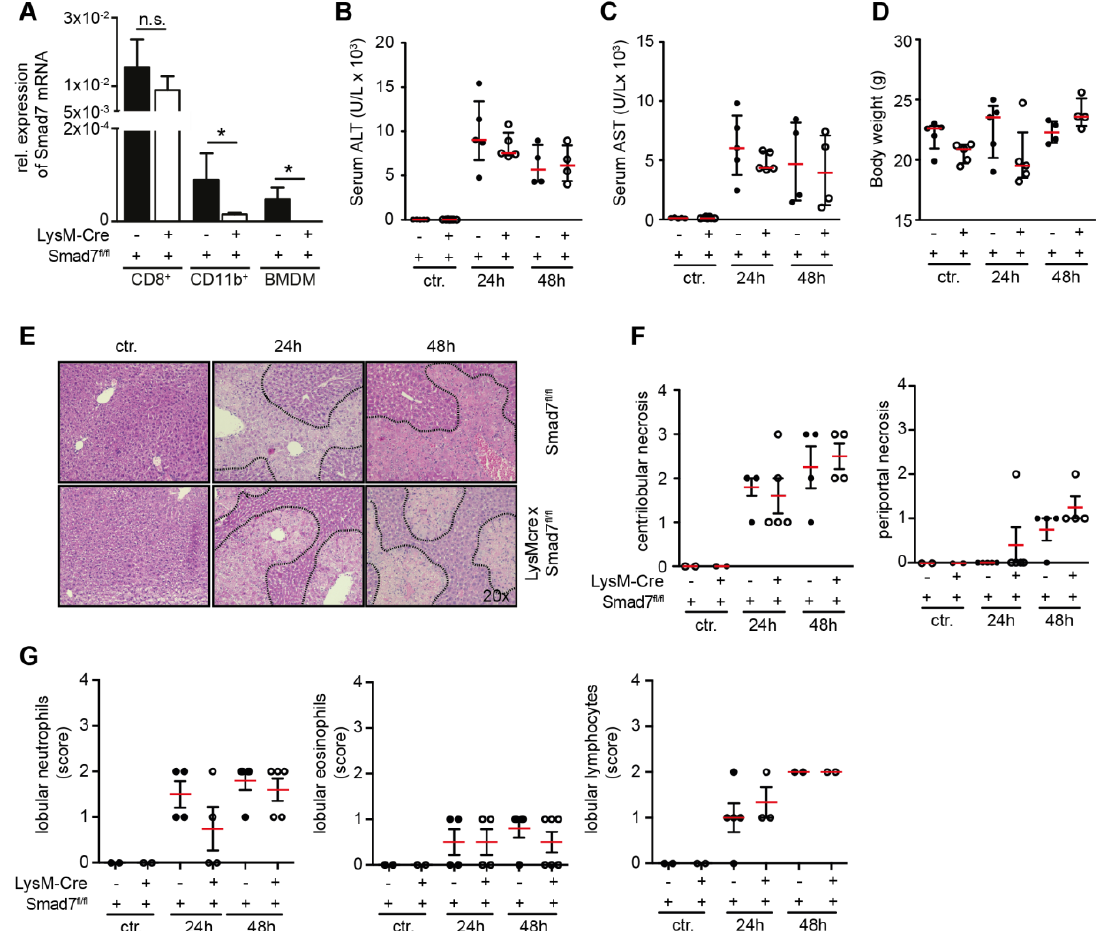
Figure 1. Liver enzymes and histological damage parameters are not changed due to myeloid deletion of Smad7 after CCl 4 administration. ( A ) Smad7 mRNA expression by quantitative real time PCR on splenic CD11b+, CD8+ and bone-marrow-derived macrophages (BMDMs) from Smad7 fl/fl and LysM-Cre Smad7 fl/fl littermates ( n = 4). ( B – G ) The 8- to 10-week-old Smad7 fl/fl and LysM-Cre Smad7 fl/fl littermates were injected with 30% CCl 4 in corn oil and sacrificed at the indicated time points. ( B) Serum ALT, ( C ) serum AST, and ( D ) body weight were determined 24 and 48 h after i.p. injection of CCl 4 . ( E ) Representative H&E staining of Smad7 fl/fl and LysM-Cre Smad7 fl/fl littermates. Representative pictures are shown at 20x magnification. ( F ) Histopathological score of centrilobular and periportal necrosis in H&E sections. ( G ) Histopathological score of lobular neutrophil, lymphocyte and eosinophil infiltration in H&E sections. Data shown are representative of three independent experiments with three to five animals per group. Error bars indicate the mean ± SEM. * p ≤ 0.05 calculated by Student’s t- test, n.s. = not significant. No other significant p -values (≤0.05) between LysM-Cre pos and Cre neg Smad7 fl/fl were present in the data from panels B – D , F and G . We injected mice with a single dose of CCl 4 i.p. and analyzed various parameters at 24 and 48 h after the application. Exposure to CCl 4 leads to centrilobular hepatic necrosis, due to the generation